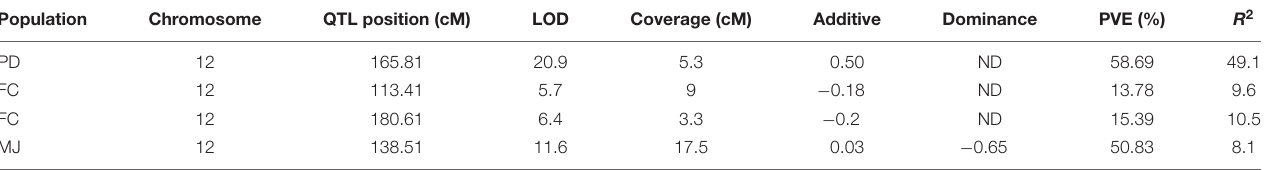
TABLE 3 | Detected QTL regions associated with fruit orientation in the three-selected populations. Population Chromosome QTL position (cM) LOD Coverage (cM) Additive Dominance PVE (%) R 2